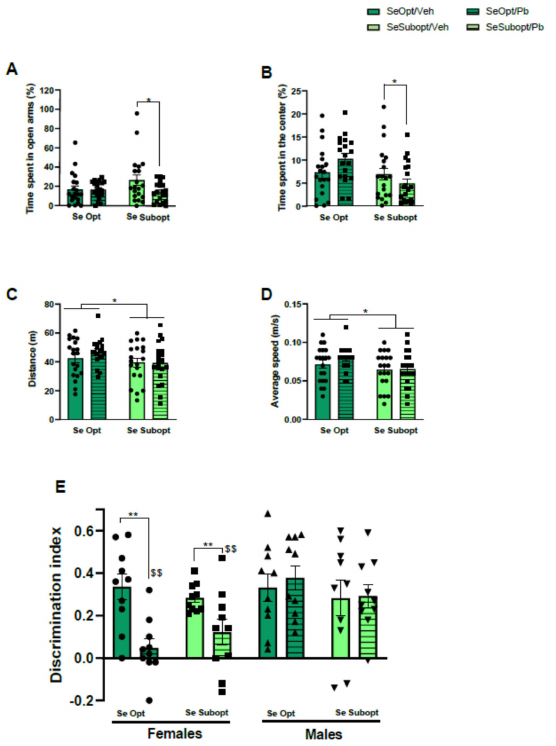
Figure 4. Behavioral assessment in young adult rats. Anxiety-like behavior measured by percentage of time spent in ( A ) open arms during the Elevated Plus Maze (EPM) test and in ( B ) the center of the arena during the Open-Field (OF) test; locomotor activity measured by ( C ) distance travelled and ( D ) average speed in the OF; long-term recognition memory performance measured by ( E ) discrimi- nation index in the Novel Object Recognition (NOR) test. Data are shown as individual value plots and are sex-pooled represented, except for NOR test; * p < 0.05, ** p < 0.01, $$ p < 0.01 Pb females vs. Pb